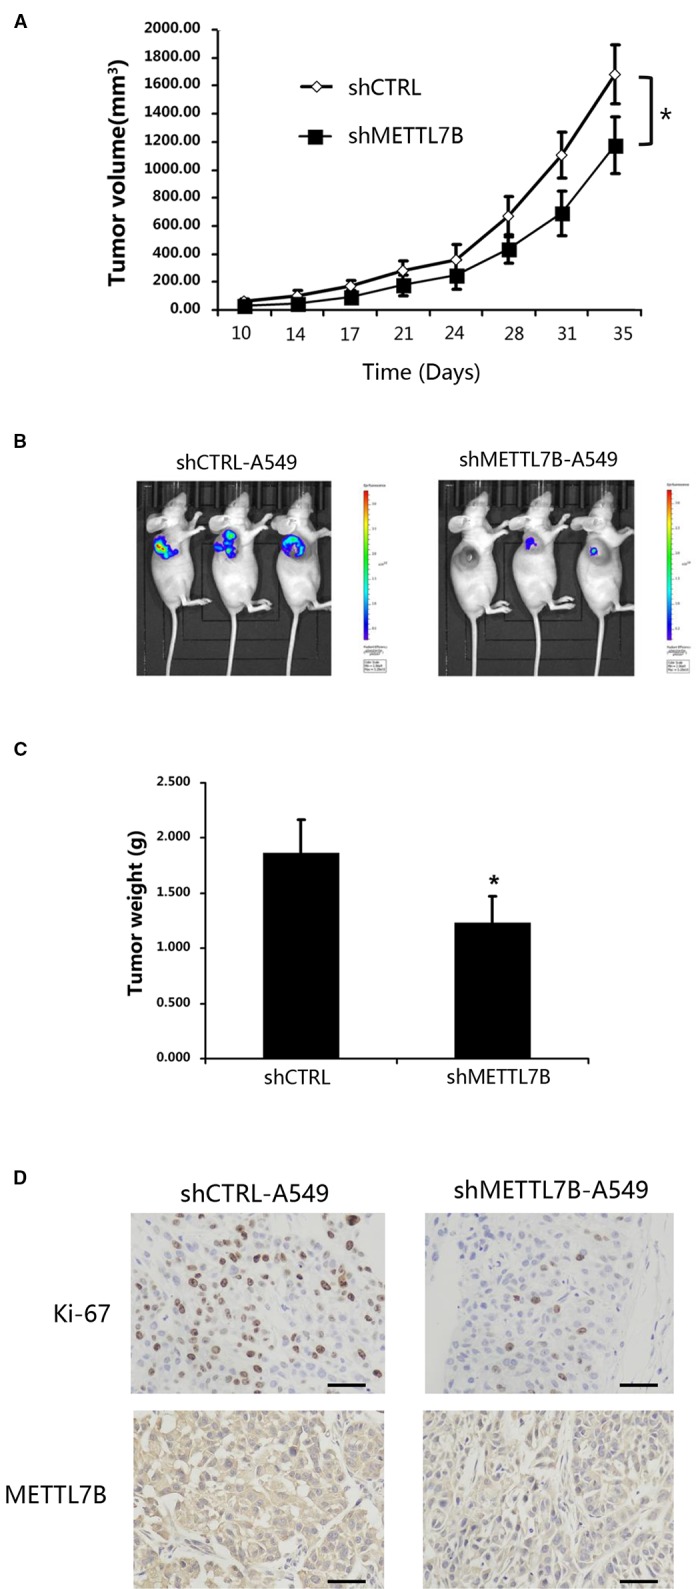
METTL7B is essential for cancer cell proliferation in vivo. ShMETTL7B-A549 or shCTRL-A549 cells were subcutaneously injected into BALB/c-nu mice. (A) Ten days after cell inoculation, tumor was measured twice a week. Tumor volumes were calculated. (B) Bioluminescent imaging of tumors with shMETTL7B-A549 or shCTRL-A549 cells in BALB/c-nu mice on day 35 (data from three representative mice of each group were shown). (C) On the 35th day, mice were sacrificed and tumor xenografts were excised and weighted. (D) Immunohistochemical staining with indicated antibodies. Scale bar, 50 μm. (Data represent mean ± S.D, *p < 0.05 indicates significant difference between the groups. Five mice were used for each group).